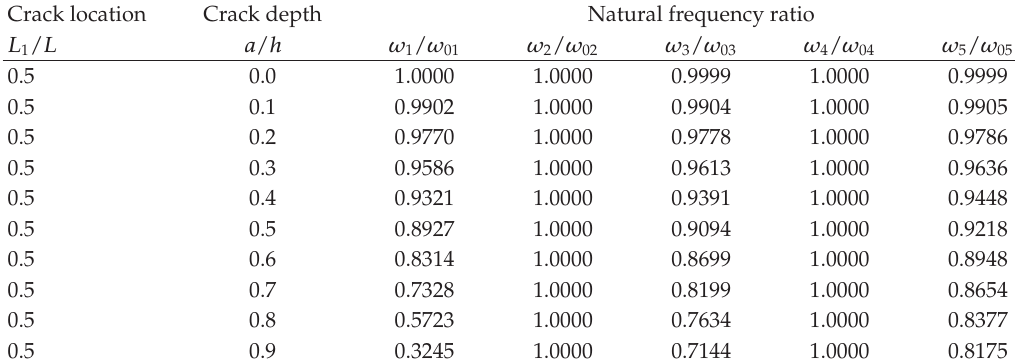
Table 2: Natural frequency ratio with the crack depth at location